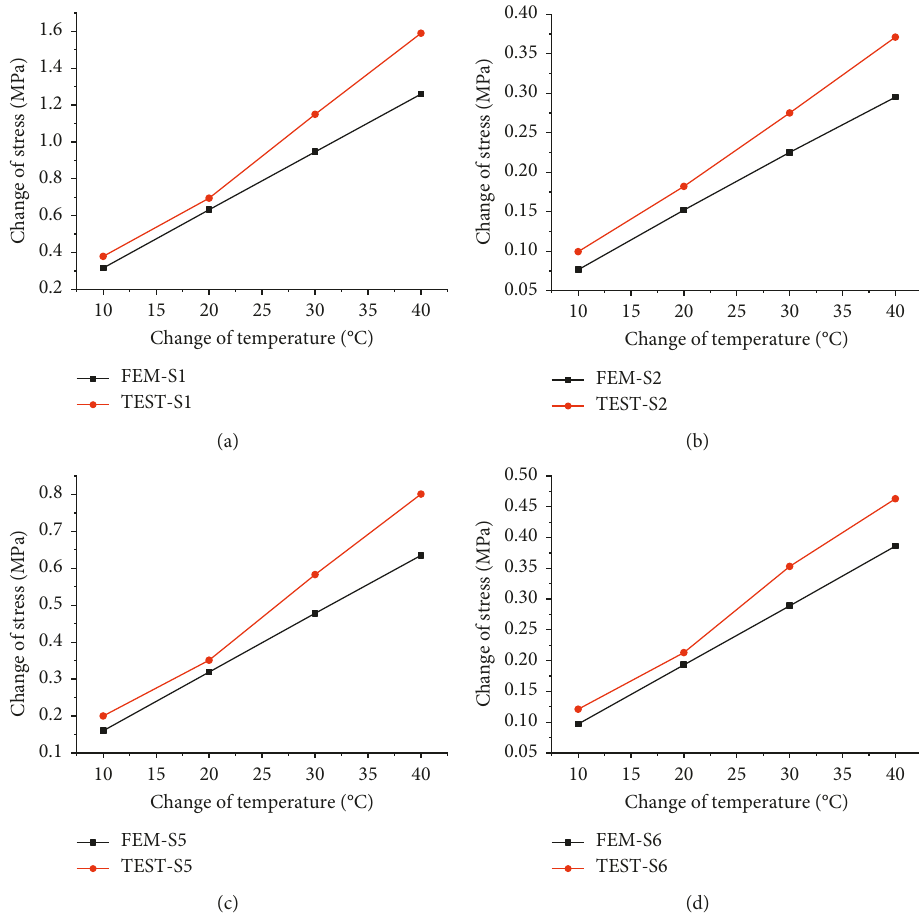
Figure 19: Comparison of the change in the USSM stress in the experiments and finite element numerical simulations under the full-span load. Change in the force of (a) S1, (b) S2, (c) S3, and (d) S6 under the full-span